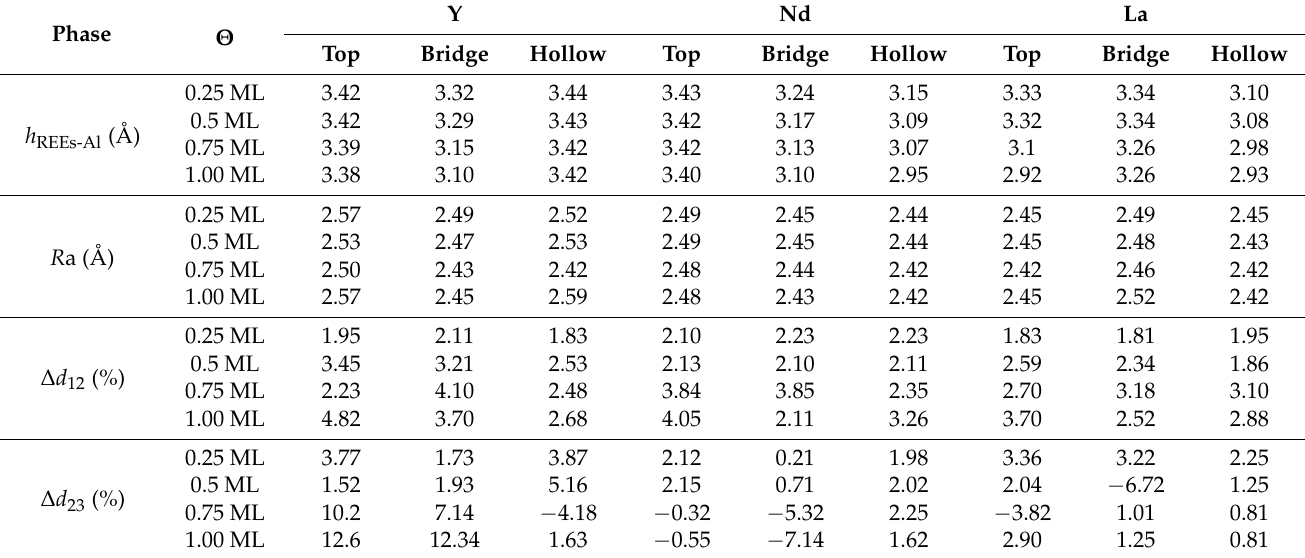
Table 3. The vertical height ( h REEs-Al ), the bond length ( R a), and the changed ratio of interlayer distances ( ∆ d 12 and ∆ d 23 ) after REE atoms were adsorbed on kaolinite (001) surface.